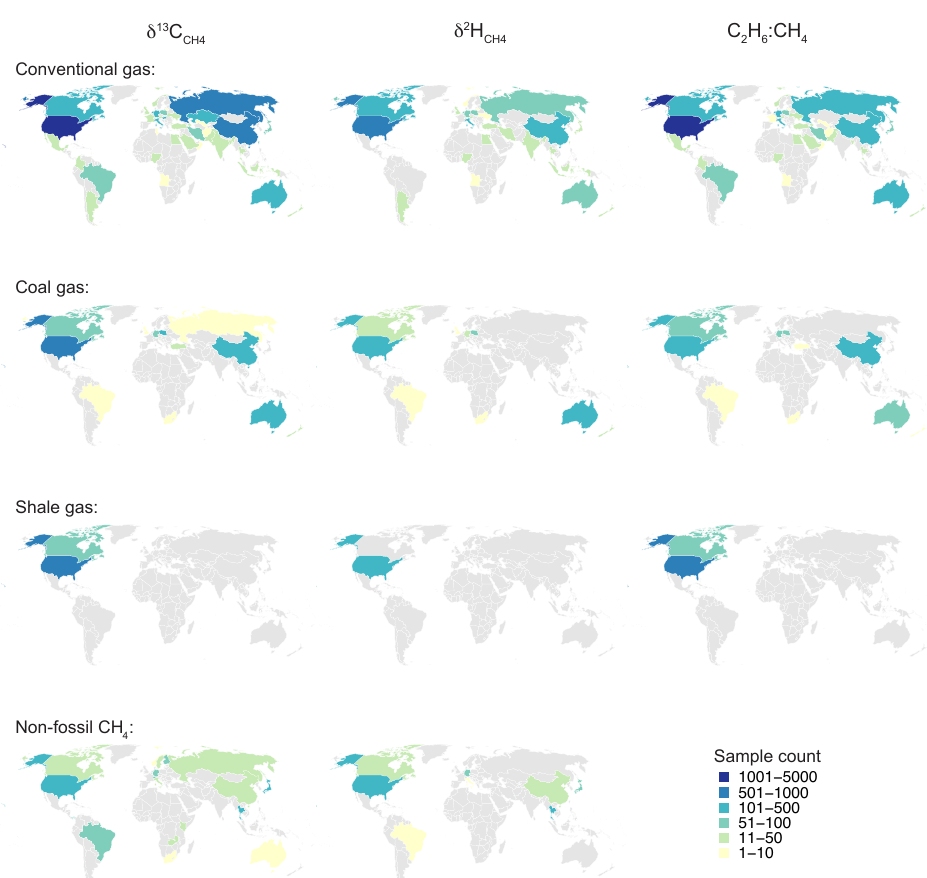
Figure 2. Global maps of country-specific sample counts for conventional gas, coal gas, shale gas, and non-fossil gas by geochemical